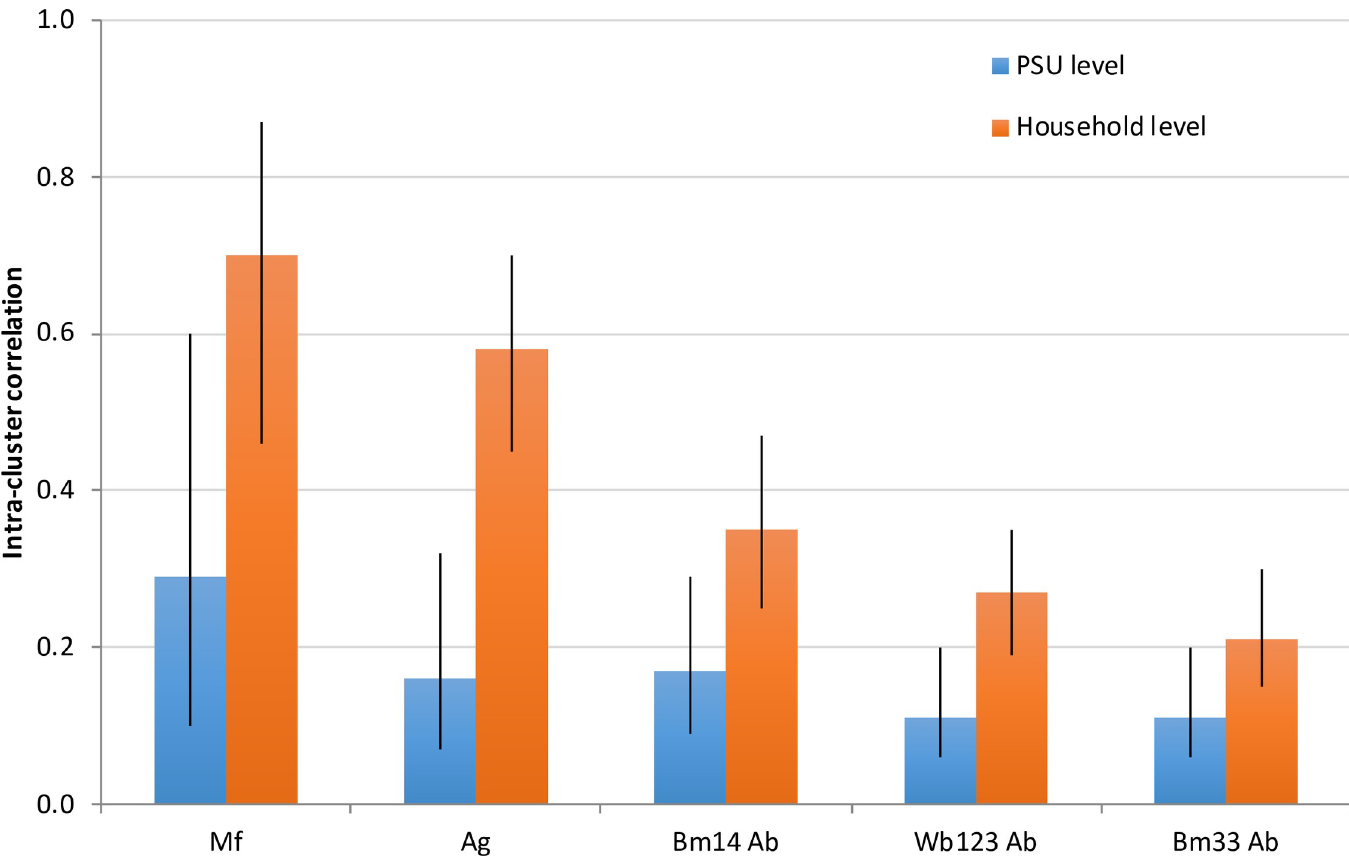
Fig 9. Intra-cluster correlation (ICC) and 95% CI at PSU and household levels for positive results for microfilaria, Ag, and antibodies (Bm14, Wb123, and